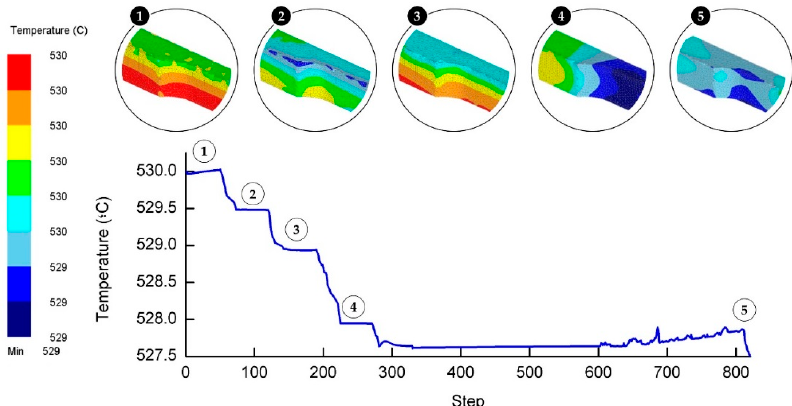
Figure 9. Temperature recorded for HPF process at each simulation step.